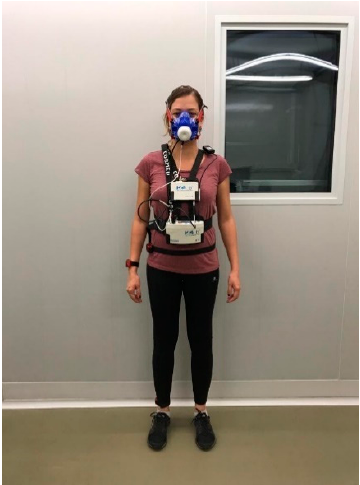
Figure 1. Equipment disposition during the experiments.